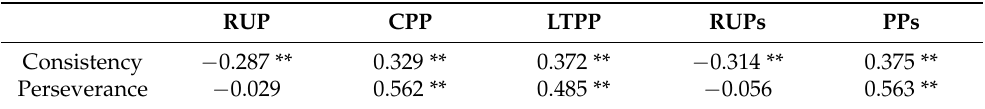
Table 4. Pearson correlations between the Grit-S factors, the original factors of the Motivational Persistence scale and the factors adapted to the Spanish population. RUP CPP LTPP RUPs PPs